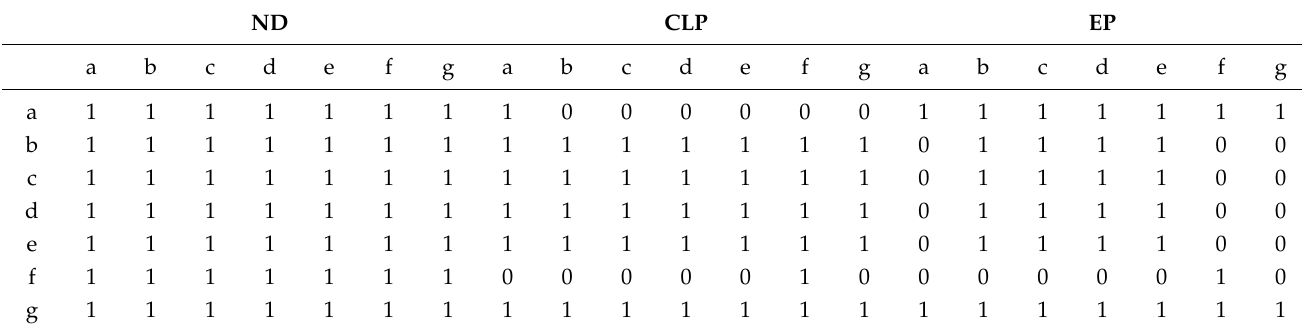
Table 3. Conversion cost matrix.